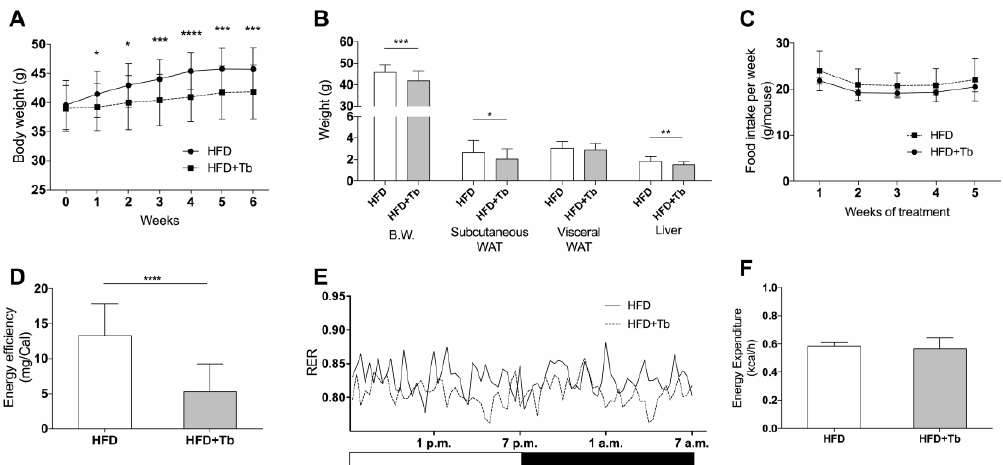
Figure 1. Tributyrin (Tb) treatment reduced body weight gain in obese mice. ( A ) Measurement of body weight of mice during the treatment. ( B ) Analysis of body weight (BW), white adipose tissue (WAT) and liver weight ( n = 31–37 mice per group for BW and 27–37 mice per group for the other samples). ( C ) Food consumption during the experimental protocol ( n = 13–16 mice per group). ( D ) Energy e ffi ciency of the body weight was calculated as mg gained divided by energy intake (Cal, n = 13–15 mice per group). ( E ) Respiratory exchange ratio obtained from the ratio of VCO 2 / VO 2 ( n = 2 mice per group). ( F ) Energy expenditure of individual mice ( n = 2, 3 mice per group). Results were obtained from high-fat diet (HFD)-fed mice for 14 weeks and treated with Tb or placebo during the last 6 weeks. Data are presented as mean ± SD. **** p < 0.0001, *** p < 0.001, ** p < 0.01, * p < 0.05 HFD vs. HFD + Tb, Student’s t -test.